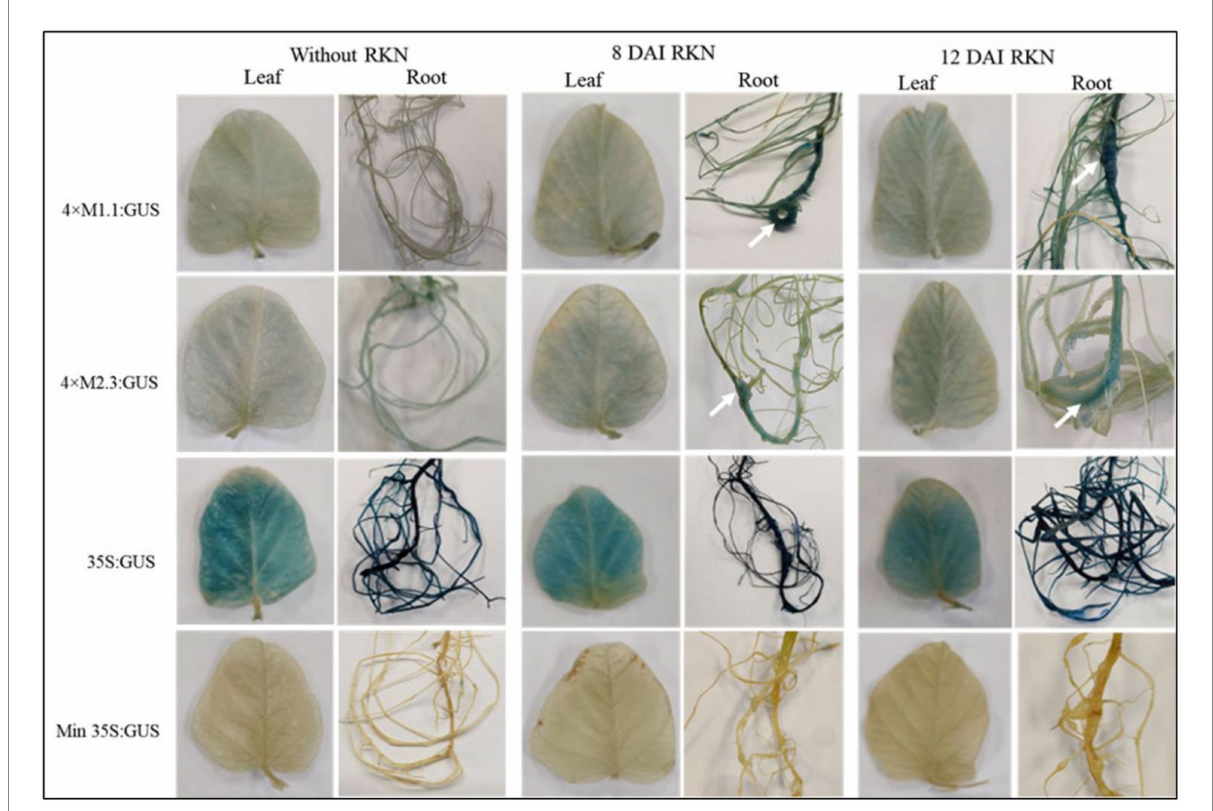
FIGURE 3 Histochemical GUS activity in leaves and roots of transgenic soybean containing the individual promoter-GUS construct uninfected or infected with root-knot nematode (RKN, Meloidogyne incognita ) at 8 and 12 days after inoculation (DAI). Arrows indicate localized GUS expression within the nematode-induced galls. Three independent transgenic lines and six plants from each line were used for 4 × M1.1 and 4 × M2.3 promoter-GUS constructs. One transgenic line and six plants from the transgenic line were used for 35S and minimal (Min) 35S promoter-GUS constructs. A similar GUS expression was observed from each